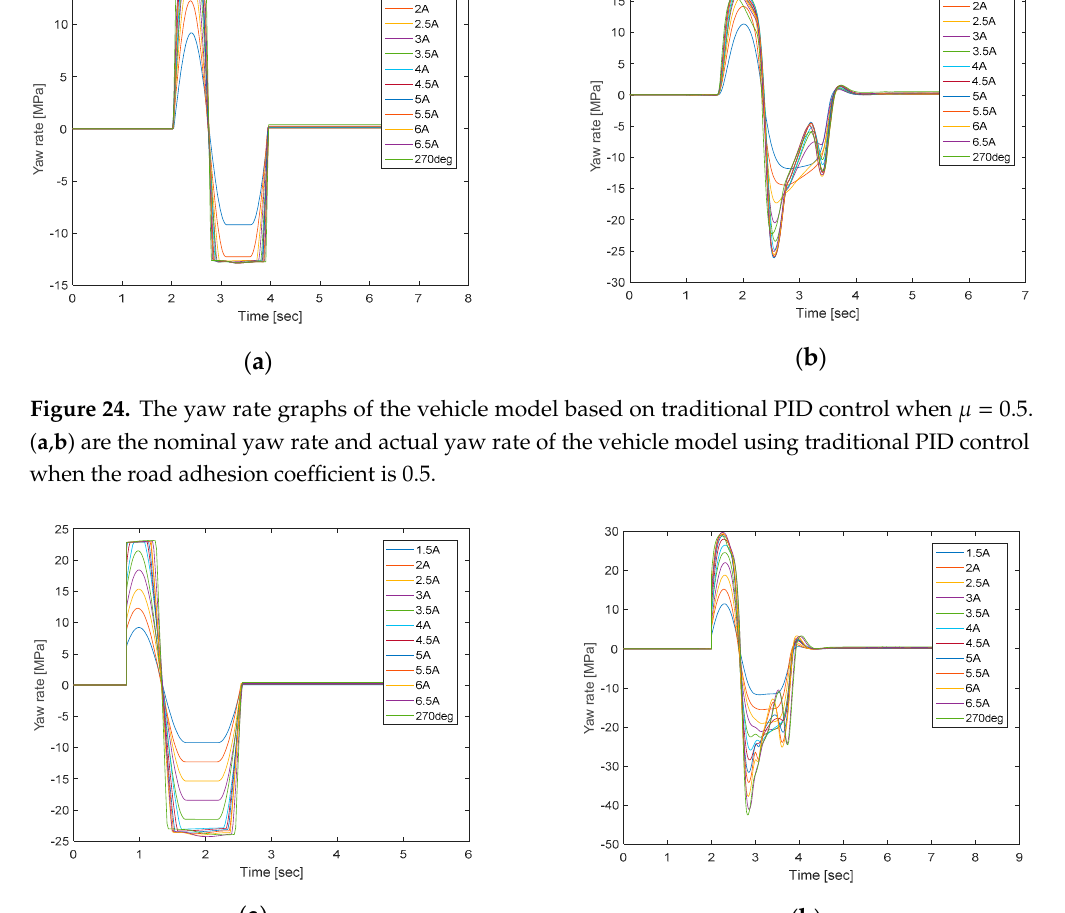
Figure 25. The yaw rate graphs of the vehicle model based on traditional PID control when 𝜇 = 0.8. ( a , b ) are the nominal yaw rate and actual yaw rate of the vehicle model using traditional PID control when the road adhesion coefficient is 0.8.